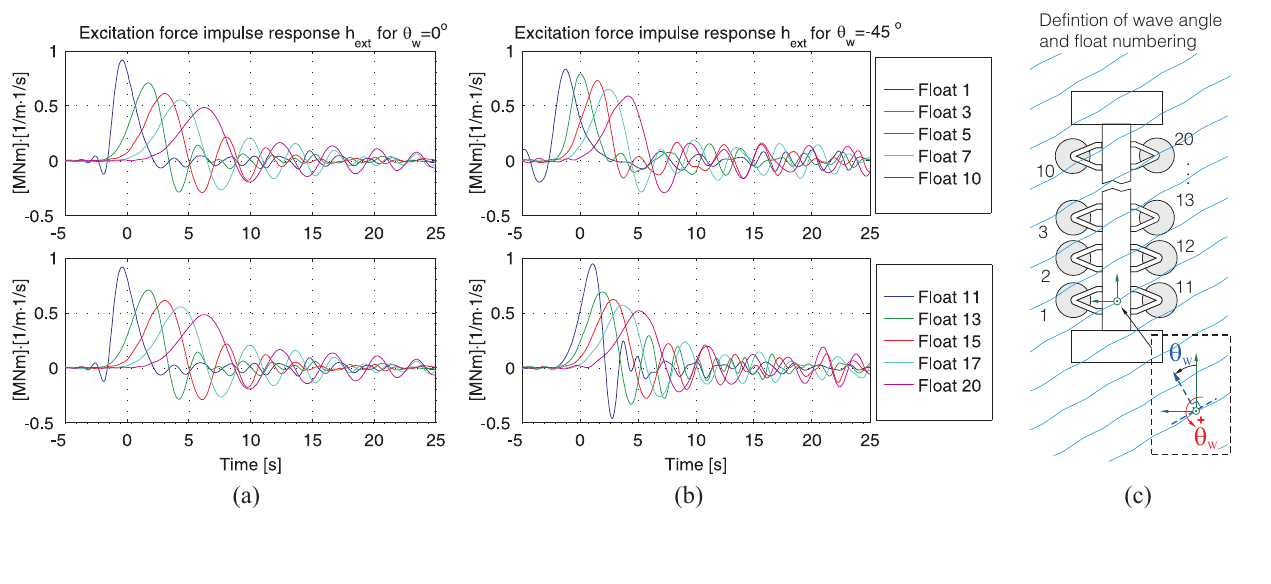
= 0 ◦ ; ( b ) is for wave direction, η w